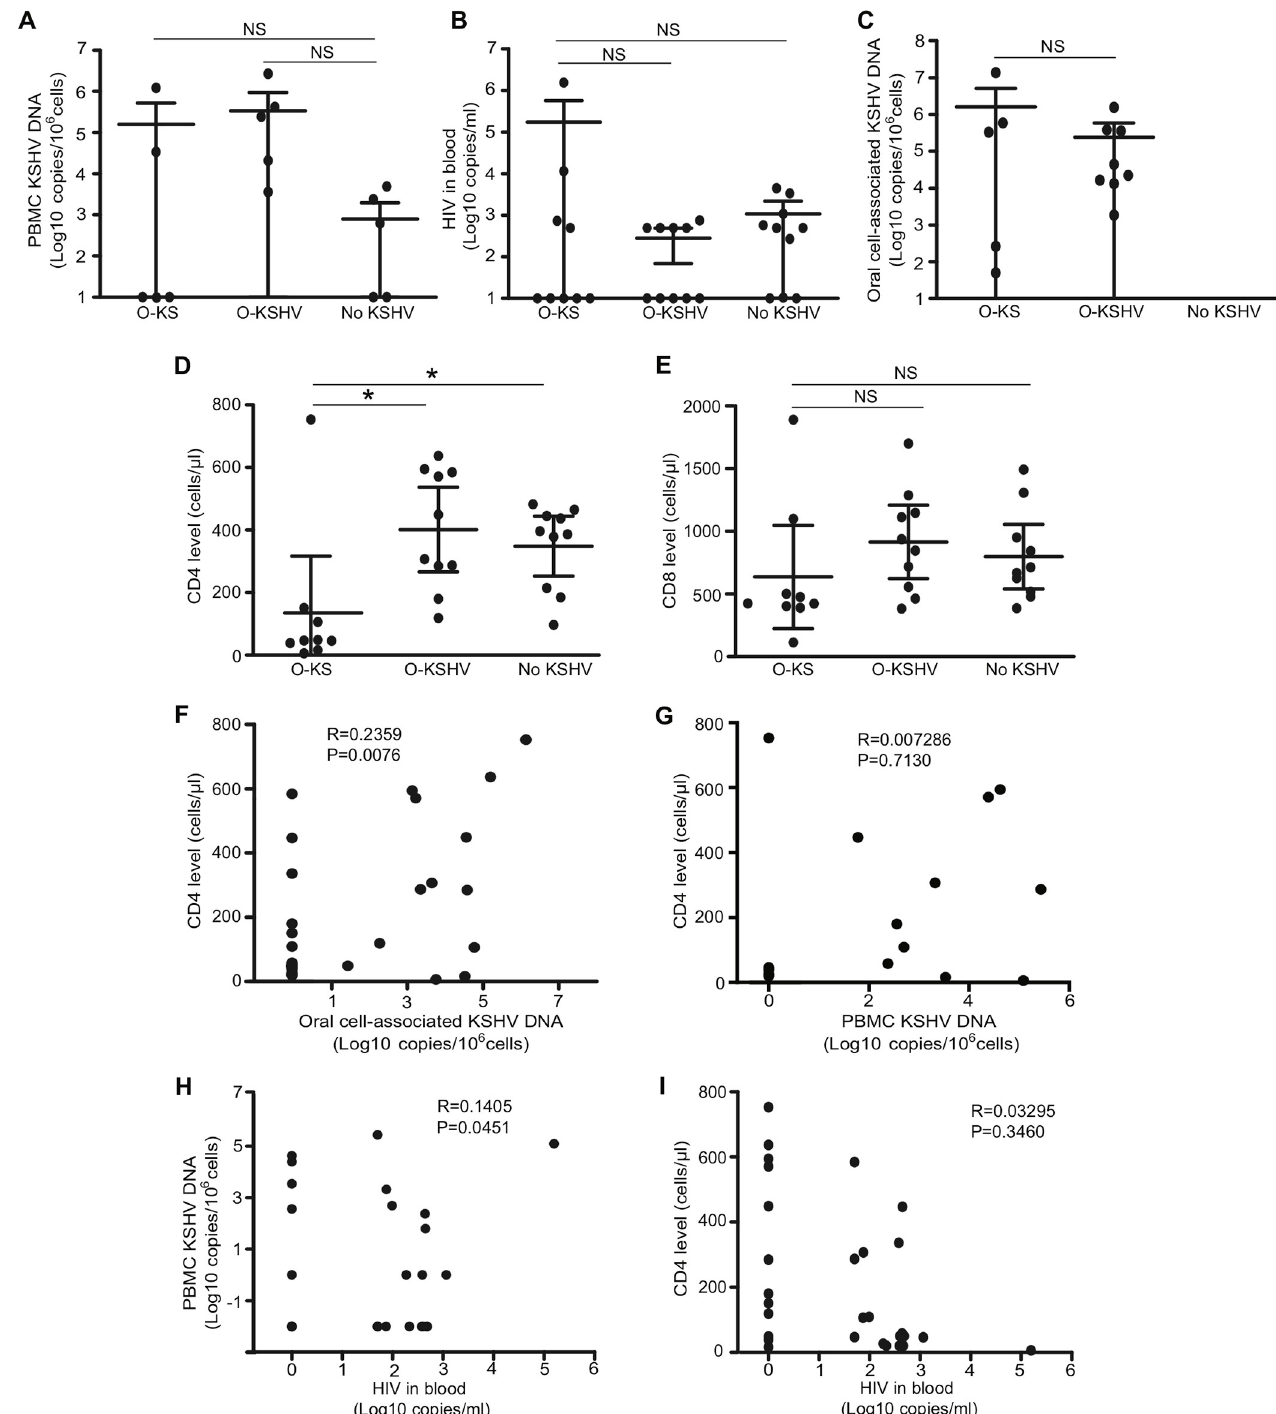
Fig 1. Viral and immunological status in three studied groups of HIV/KSHV-coinfected individuals. (A-C) Quantification of PBMC KSHV DNA (A), HIV load (B), and oral cell-associated KSHV DNA (C). (D-E) Quantification of levels of CD4+ T cell count (D) and CD8+ T cell count (E). (F) Correlation of CD4 + T cell count with oral cell-associated KSHV DNA. (G) Correlation of CD4+ T cell count with PBMC KSHV DNA. (H) Correlation of HIV load and PBMC KSHV DNA. (I) Correlation of CD4+ T cell count with HIV load. P-value � 0.05 ( � ) was considered as significant. NS indicates not significant (P-value � 0.05).